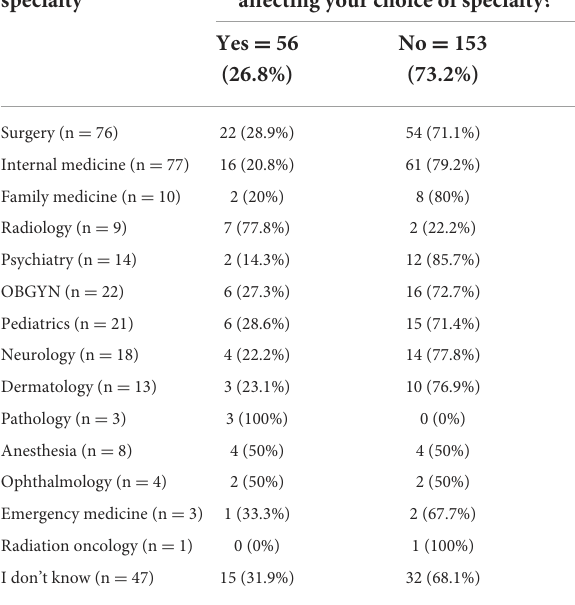
TABLE 2 Choice of specialty by the effect of AI advancement on the choice. Choice of